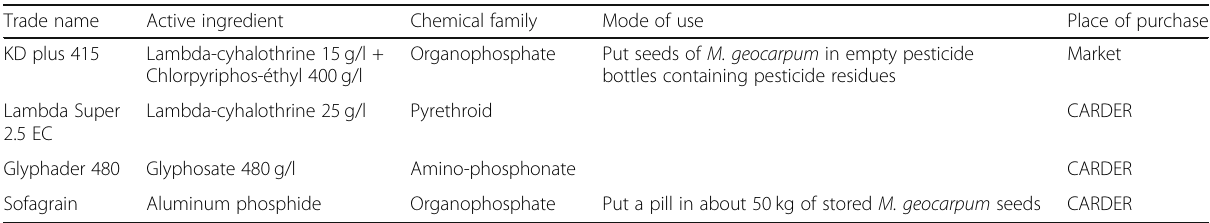
Table 4 List of chemical insecticides used by farmers to protect Kersting ’ s groundnut grains against storage insect pests and their utilization